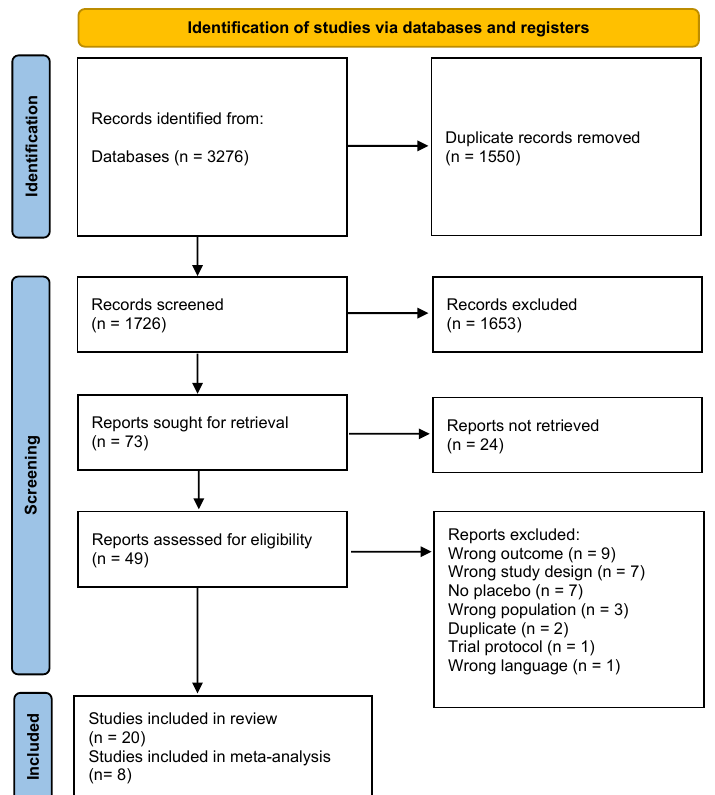
Figure 1. Prisma study flow diagram 2020. Table 1. Publications selected for the systematic review, including study characteristics.